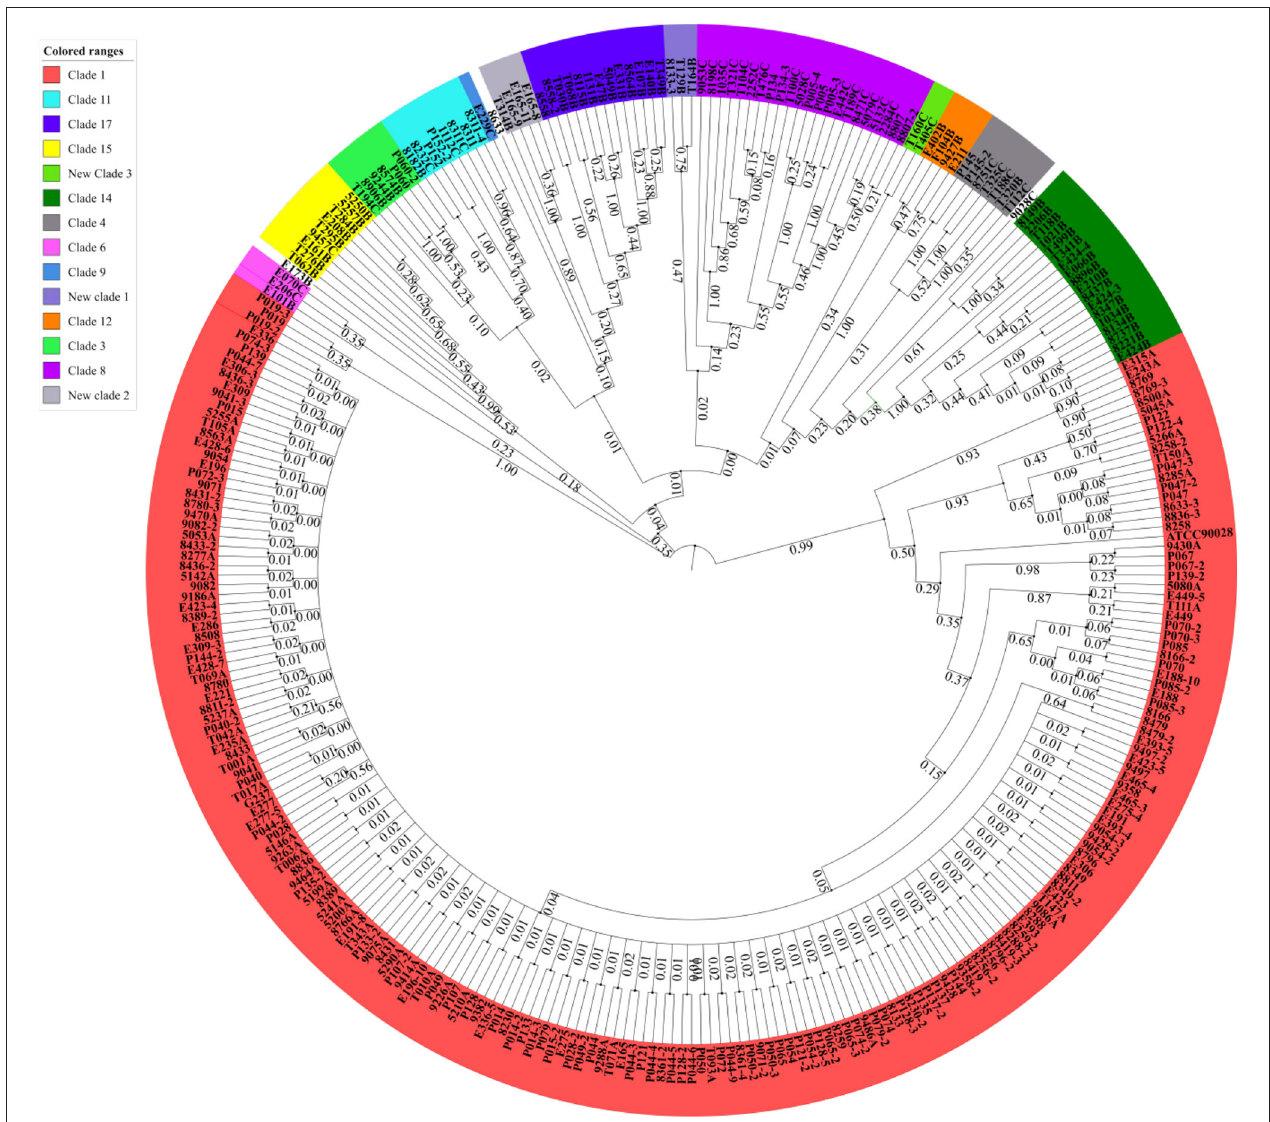
FIGURE 1 | Candida albicans isolated from VVC patients were mainly clustered in MLST clade 1. The MLST phylogenetic tree was constructed by UPGMA according to the p-distance model ( p = 0.04) with 1,000 replicates for bootstrap testing. In total, 306 strains were clustered into 14 clades and three singletons, including 11 known clades and three novel clades. Clade 1 was the largest group, accounting for 66% of the total